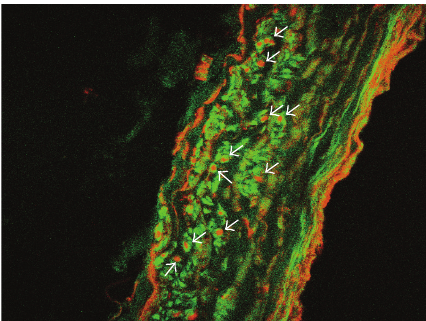
Figure 4: Representative image showing distribution of immunore- active MBP and smooth muscle actin within 2mm human airway following overnight incubation with human eosinophils. Immunoreactive actin (green) and MBP (red) are shown. Two patterns of extracellular MBP deposition are noted broad linear deposition along luminal and abluminal surfaces, and (arrows) discrete focal deposition within the airway media, especially in the vicinity of airway myocytes (confocal microscopy 400x).